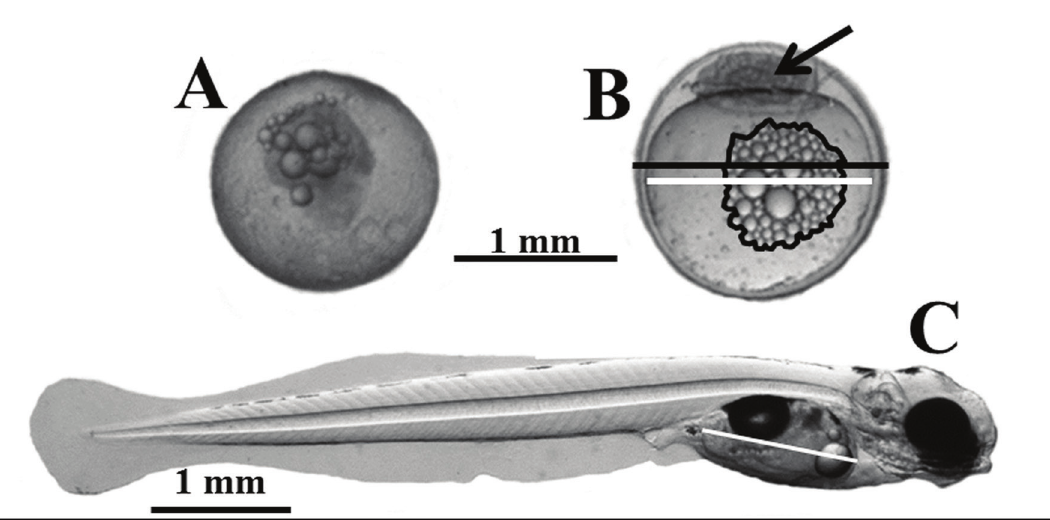
Fig. 1. A. General aspect of unfertilized egg and B. morphometric measurement procedures for pejerrey eggs in blastula stage (arrow). White and black lines indicate the egg diameter and the yolk diameter, respectively. Oil droplets area is surrounded by a black line. C. newly hatched larva; the white line indicates the length of the yolk